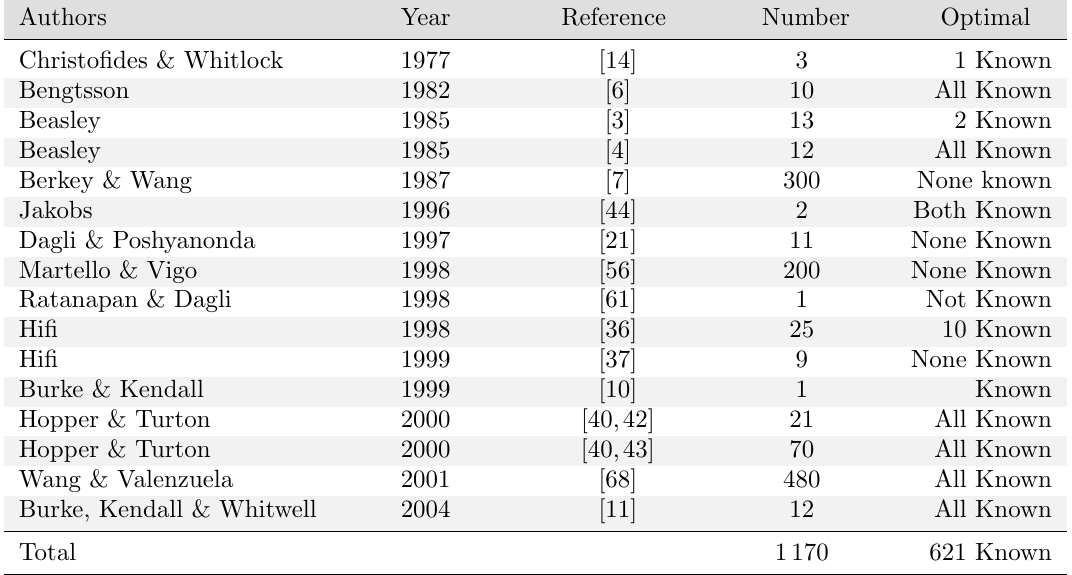
Table 1: Benchmark problem instances used to evaluate the strip packing algorithms cited in § 2. Ten of the benchmark sets [3, 4, 6, 7, 14, 21, 36, 37, 56, 61] were randomly generated subject